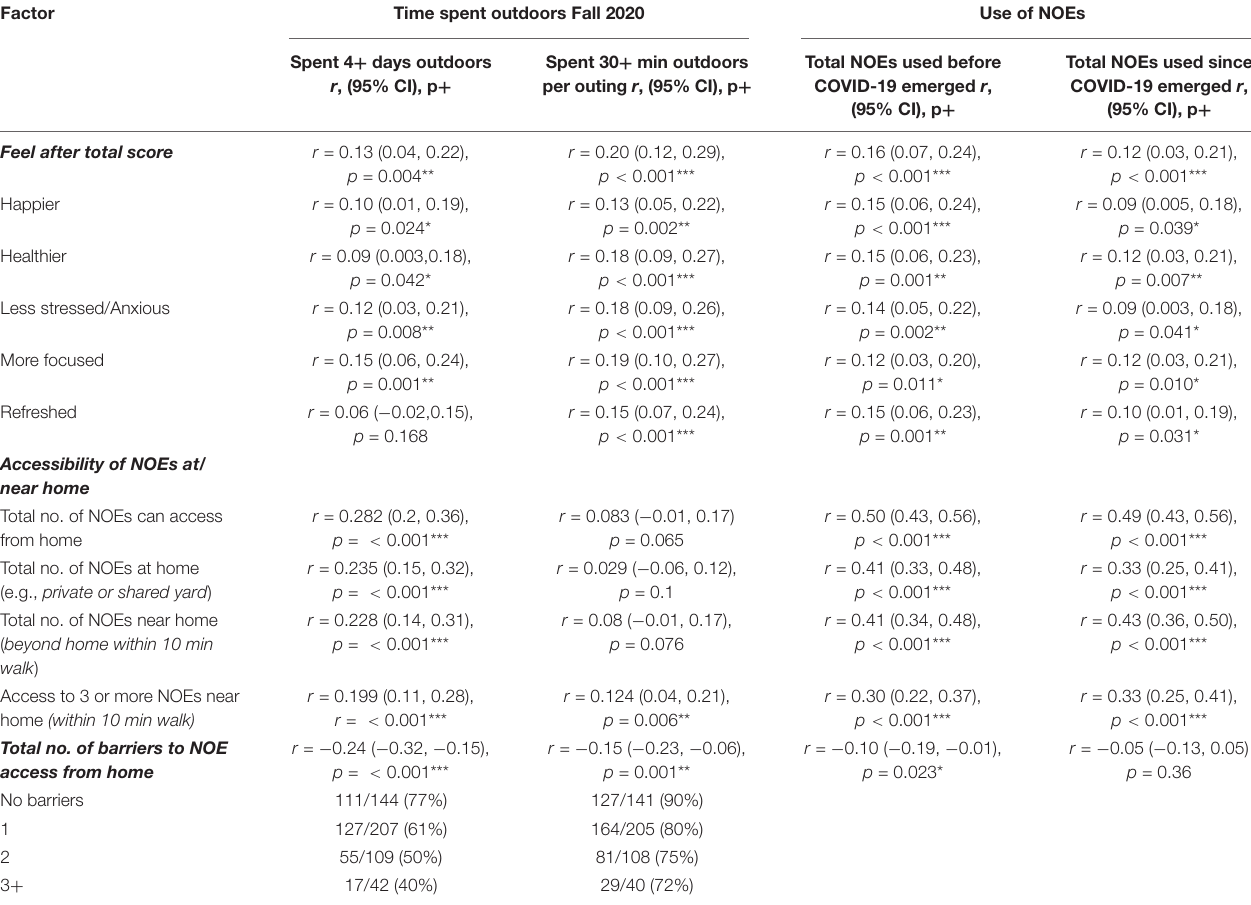
TABLE 7 | Factors influencing time spent outdoors and use of NOEs.